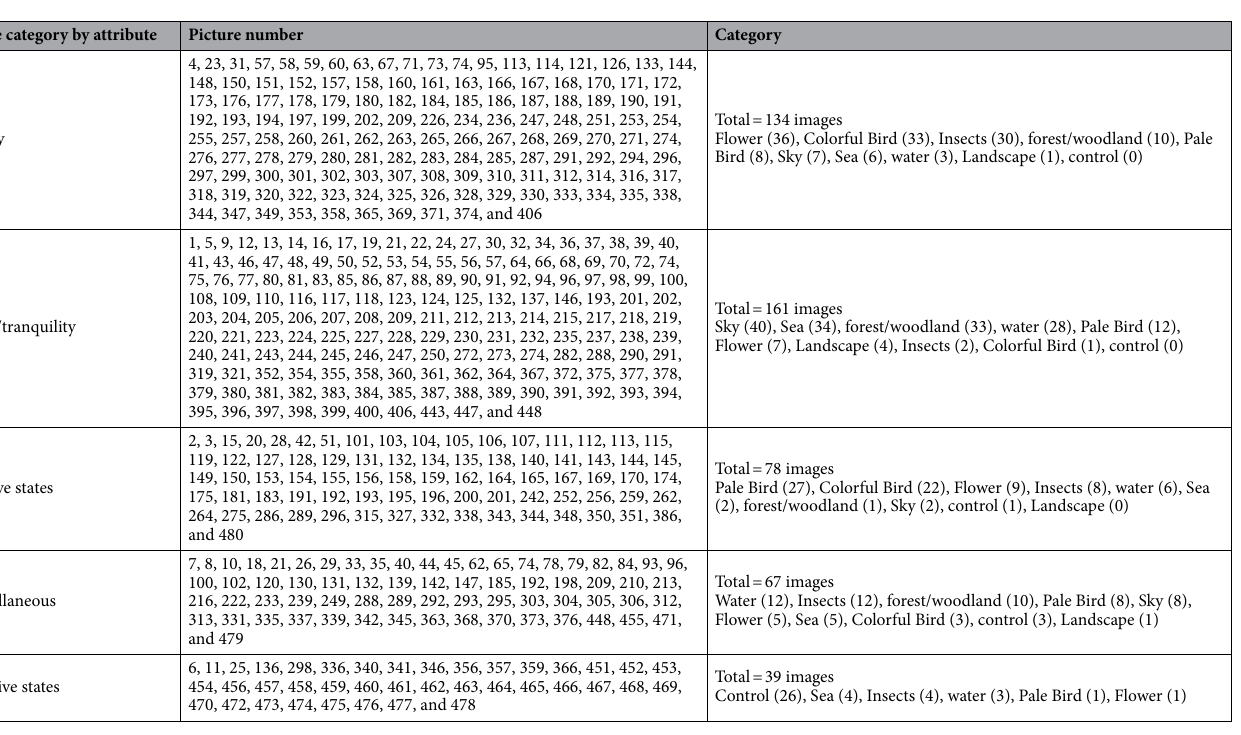
Table 6. Classification of nature pictures by attribute groups. Picture categories: Water, 1–50; Forest/ Woodland, 51–100; Pale Bird, 101–150; Colorful Bird, 151–200; Sky, 201–250; Flower, 251–300; Insects, 301–350; Sea, 351–400; Landscape, 406–448; and Control,